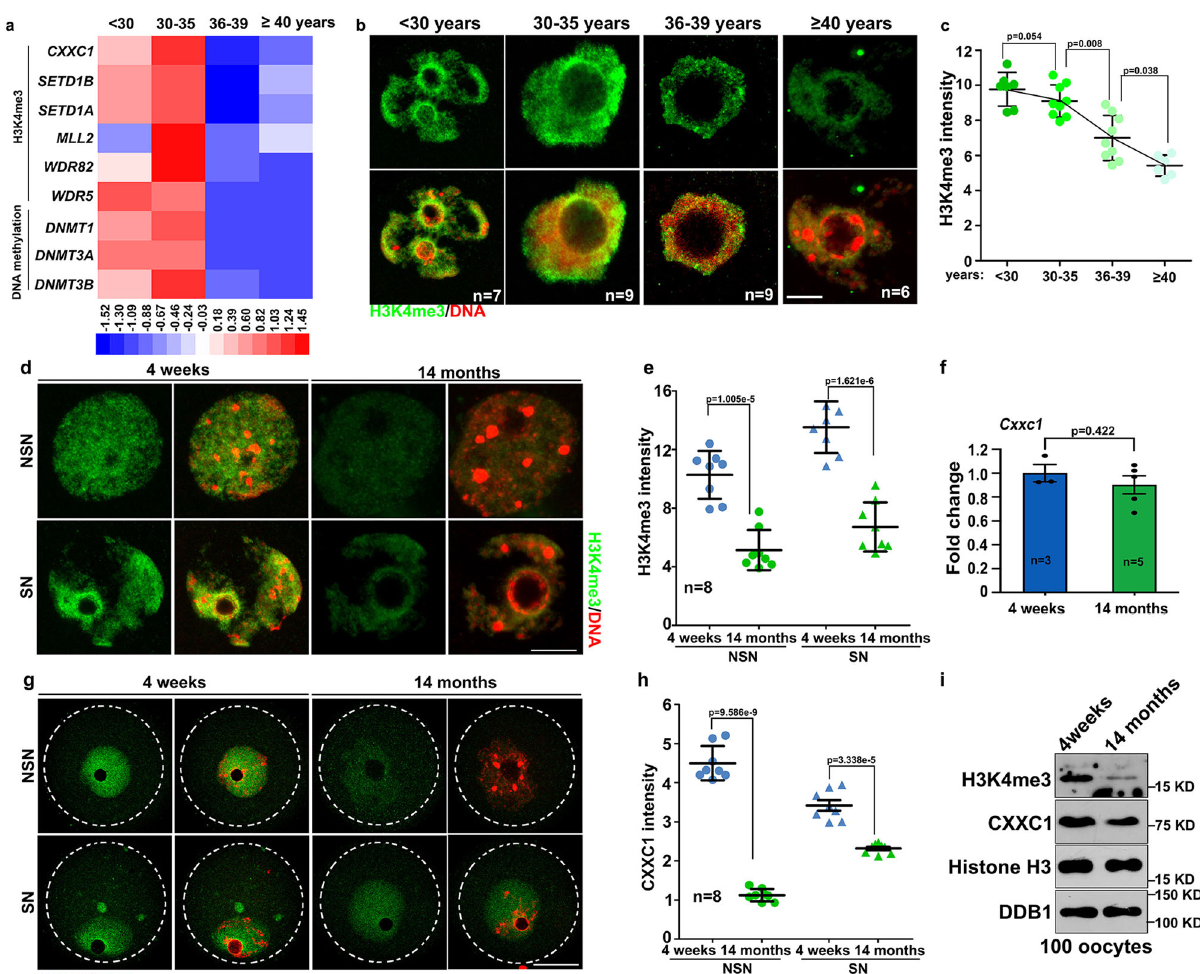
Fig. 4 Age-associated changes of trimethylated histone H3 lysine-4 (H3K4me3) levels in human and mouse oocytes. a Heat maps showing level changes in transcripts encoding epigenetic regulators in the indicated functional categories. b Immuno fl uorescence of H3K4me3 in GV stage-arrested oocytes from women at the indicated ages. The number of examined oocytes is indicated (n). Only the nuclei of oocytes are displayed. Scale bar = 10 µ m. c Quanti fi cation of H3K4me3 immuno fl uorescence signals in ( b ). d Immuno fl uorescence of H3K4me3 in GV stage-arrested fully grown oocytes derived from 4-week and 14-month mice. Only the nuclei of oocytes are displayed. Scale bar = 10 µ m. NSN: oocyte with non-surrounded nucleolus; SN: oocyte with surrounded nucleolus. e Quanti fi cation of H3K4me3 immuno fl uorescence signals ( d ). n = 8 oocytes for each experimental group. f Quantitative RT-PCR results showing Cxxc1 mRNA levels in GV stage-arrested fully grown oocytes derived from 4-week and 14-month-old mice. n = 3 biologically independent samples in oocytes of 4 weeks old female mice; n = 5 biologically independent samples in oocytes of 14 months old mice. g Immuno fl uorescence of CXXC1 in GV stage-arrested fully grown oocytes derived from 4-week and 14-month mice. Oocytes are outlined by broken circles. Scale bar = 20 µ m. h Quanti fi cation of CXXC1 immuno fl uorescence signals ( g ). n = 8 oocytes for each experimental group. i Western blots of indicated proteins in fully grown GV oocytes derived from 4-week and 14-month mice. Histones H3 and DDB1 were used as the loading controls. In c, e , f and h , data are presented as mean values ± SEM P by two-tailed Student ’ s t -test. n.s.: non-signi fi cant.